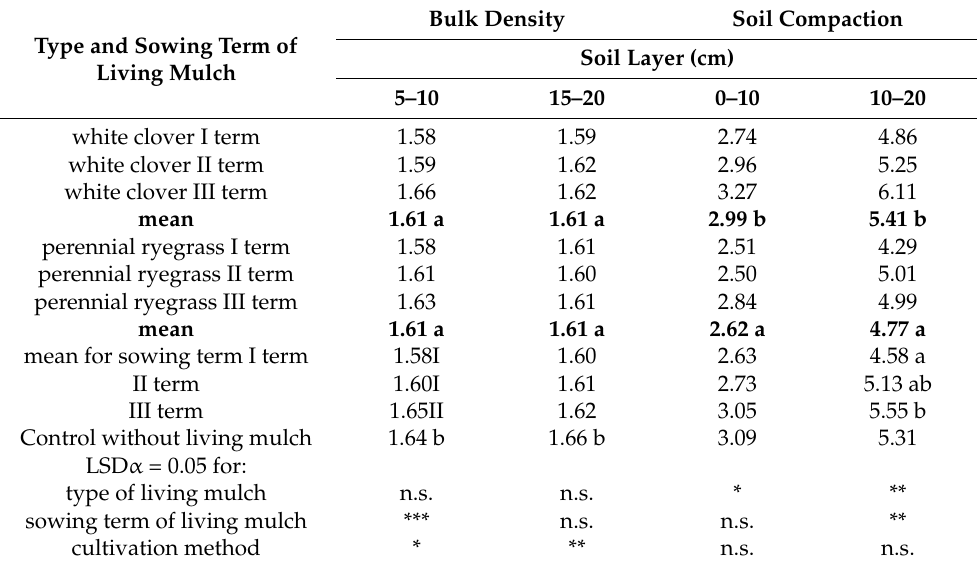
Table 5. The effect of type and sowing term of living mulch on bulk density and soil compaction in eggplant cultivation, mean for 2010–2012 (Mg m − 3